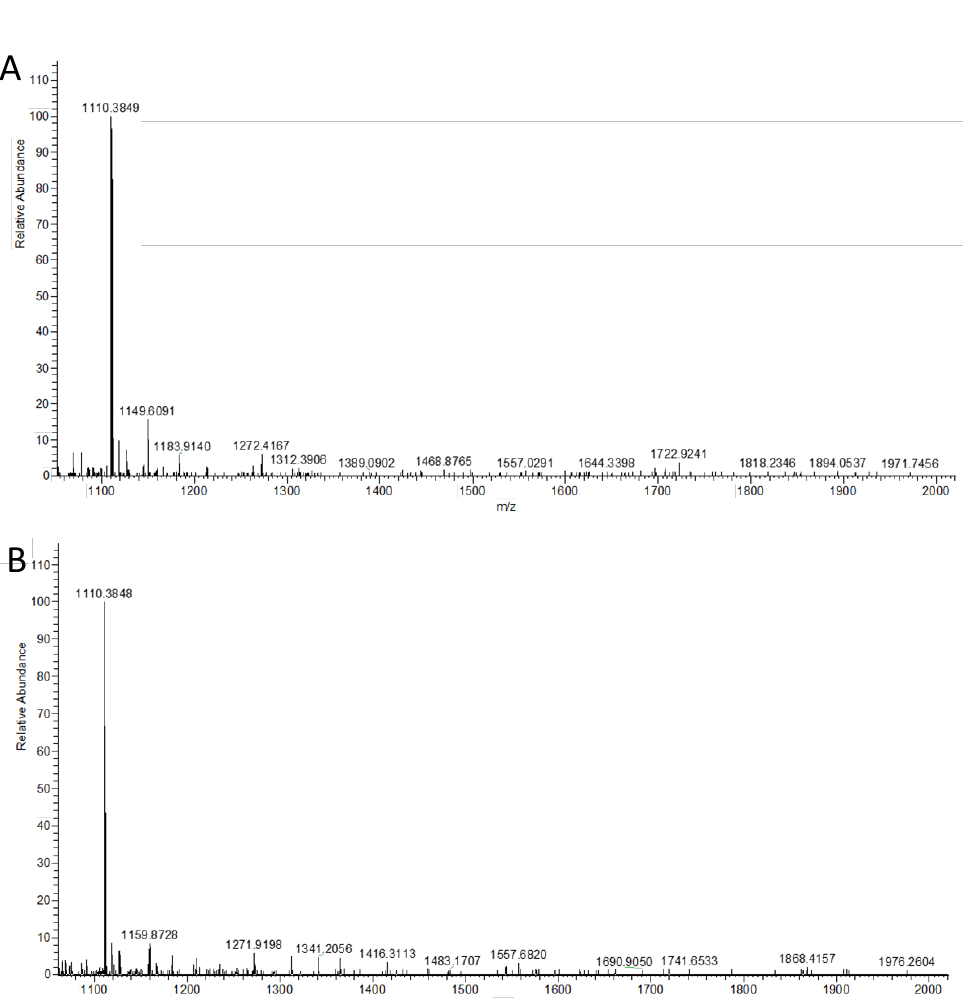
Figure 6. HRMS (negative mode) assay results for the N-glycans released from the RNase B products produced by a one-pot two-enzyme (OP2E) sialylation reaction containing Neisseria meningitidis CMP-sialic acid synthetase (NmCSS) and MBP- ∆ 89ST6GAL-I-His 6 ( A ) or MBP-CjCst-I ∆ 145-His 6 ( B ). The m / z value expected for the ionized disialyl N-glycan (Neu5Ac 2 Gal 2 GlcNAc 2 Man 3 GlcNAc 2 ) was 1110.3842. The ionized substrate ( m / z value expected 1663.5819), substrate + Cl ( m / z value expected 1675.5610), or monosialylated N-glycan ( m / z value expected 1930.6803) was not observed.